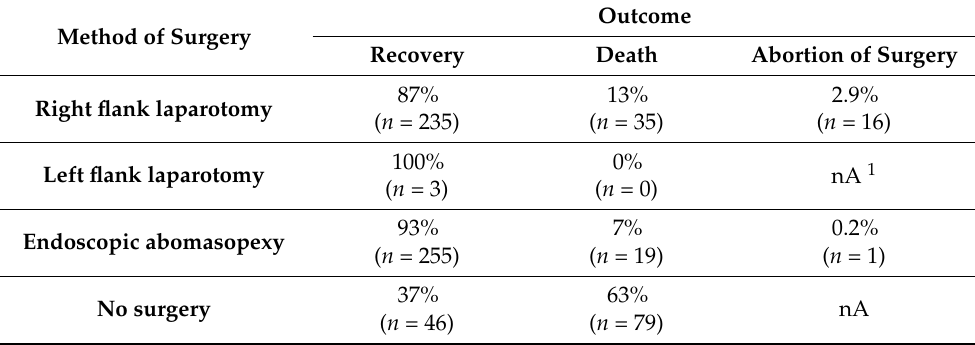
Table 4. Distribution of outcome according to method of treatment in 672 cows with left displacement of the abomasum. The number of cows in which surgery was aborted due to intraoperative findings is indicated. One animal died spontaneously following endoscopic abomasopexy. No surgery was performed in 18.6% ( n = 125) of the cows, either because the cows were treated successfully with abomasal rolling or because they were euthanized or died (4 cows died on day 0 and 12 cows on days ≤ 3). Outcome Method of Surgery Recovery Death Abortion of Surgery Right flank